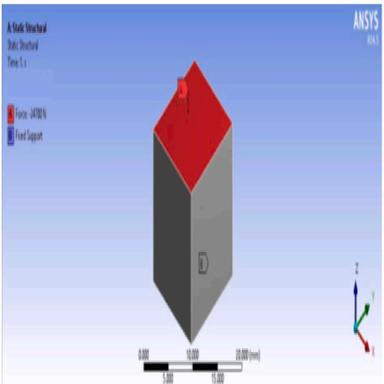
Uniaxial Compression load is applied on one end, and the other end is fixed.